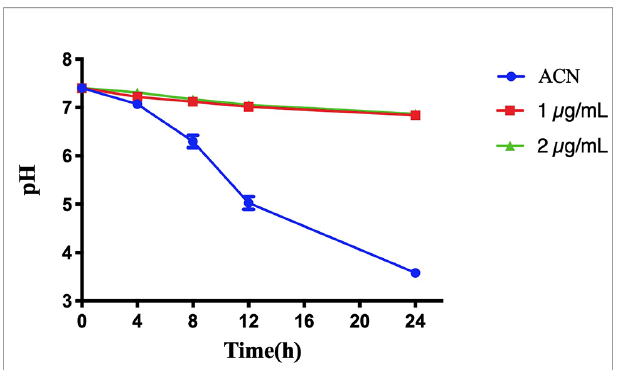
FIGURE 5 | pH change of the supernatant of Streptococcus mutans UA159 bio fi lms treated with or without 1,3-bis[3,5-bis(tri fl uoromethyl)phenyl]urea (BPU). Values are presented as means ± SDs from three independent experiments. ACN,